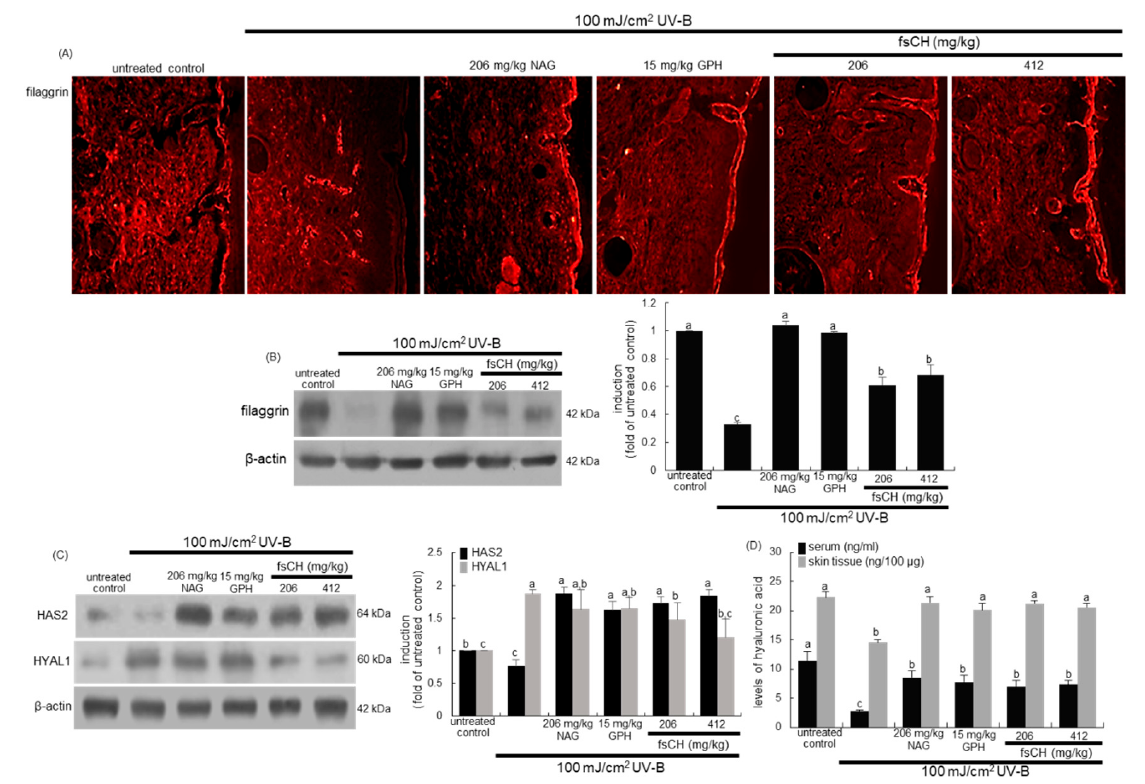
Figure 9. Effects of Pangasius hypophthalmus fish skin hydrolysates (fsCH) on skin tissue levels of filaggrin, hyaluronic acid synthase 2 (HAS2) and hyaluronidase 1 (HYAL1), and serum and skin tissue levels of hyaluronic acid of UV-B-irradiated SKH-1 hairless mice. SKH-1 hairless mice were exposed to ultraviolet-B (UV-B) radiation three times a week and treated with 206 mg/kg N-acetyl-D-glucosamine (NAG), 15 mg/kg glycine-proline-hydroxyproline tripeptide (GPH), and 206–412 mg/kg fsCH orally for eight weeks. The filaggrin localization was visualized by a Cy3-red staining ( A ). Skin tissue extracts were electrophoresed on 8–12% SDS-PAGE and subjected to Western blot analysis with a primary antibody against filaggrin, HAS2, and HYAL1 ( B , C ). β -Actin antibody was used as an internal control. The bar graphs (mean ± SEM, n = 3) in the right panels represent the quantitative results of the blot bands on the left obtained from a densitometer. Serum and skin tissue levels of hyaluronic acid were measured by using ELISA kits ( D ). Respective values in bar graphs not sharing a small letter are different at p < 0.05.